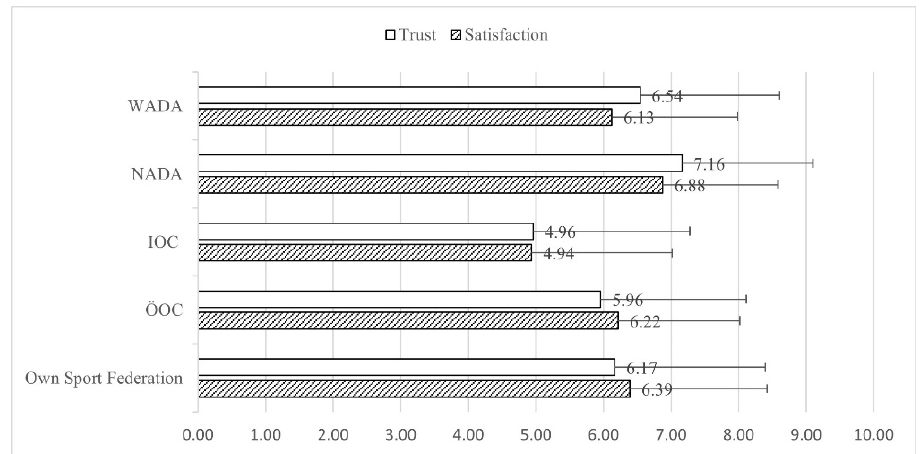
Figure 1. Trust in and satisfaction with organizations. Note: WADA = World Anti-Doping Agency, NADA = National Anti-Doping Agency, IOC = International Olympic Committee, ÖOC = Austrian Olympic Committee.